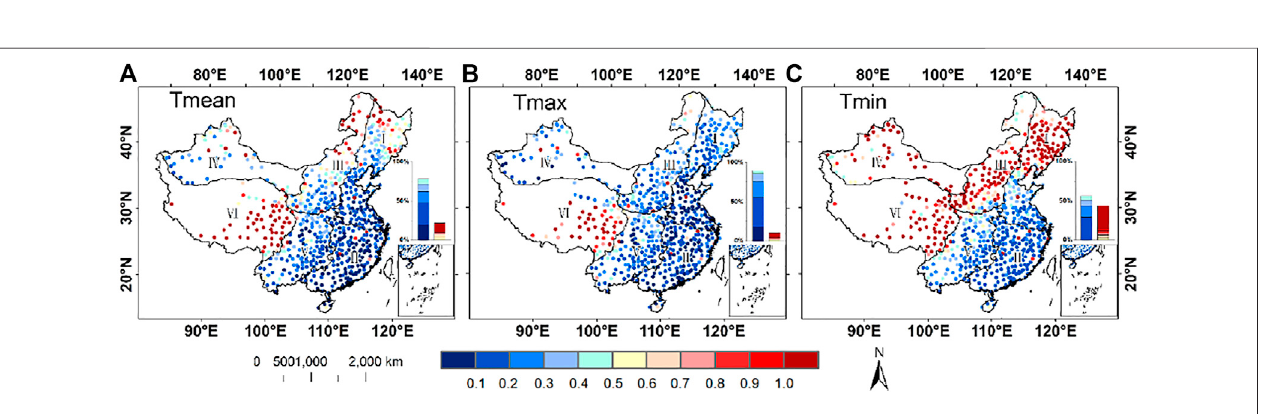
Frontiers in Environmental Science |